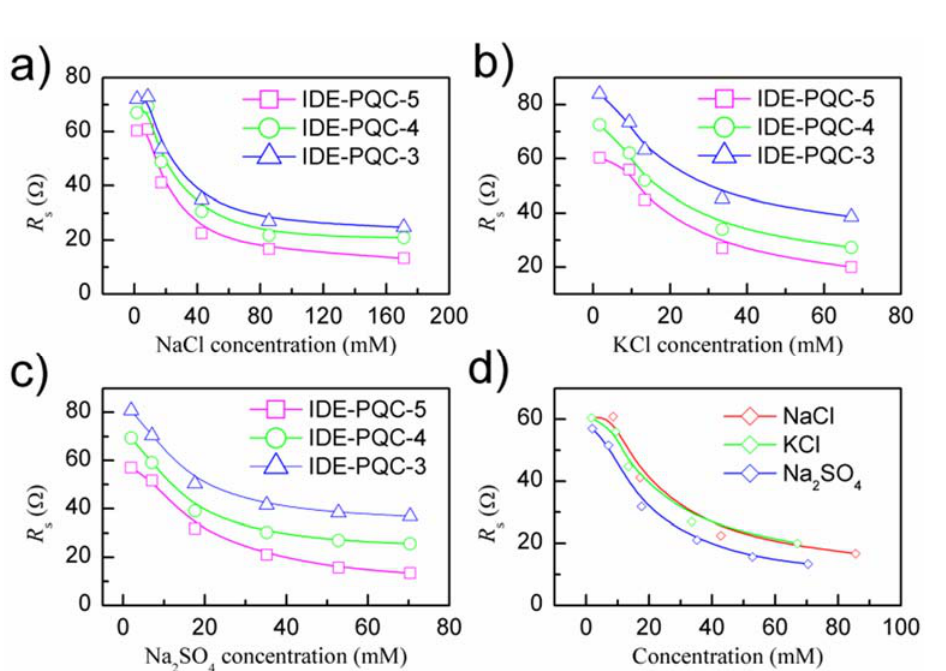
Figure 7. The series resistance R s of IDE-PQC sensor at different concentrations of ( a ) NaCl. ( b ) KCl and ( c ) Na 2 SO 4 solution, and ( d ) The comparison of the series resistance R s of IDE-PQC-5 sensor at different salts solution.